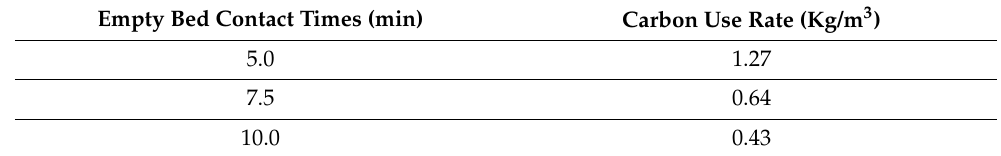
Table 7. Carbon use rate for different empty bed contact time